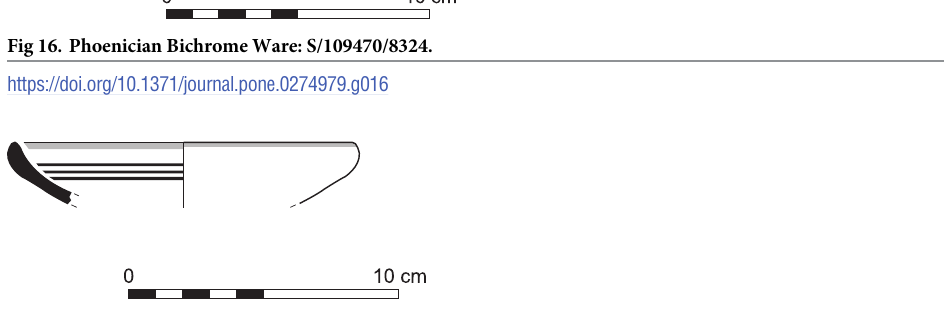
Fig 17. Phoenician Bichrome Ware: S/109455/8324.